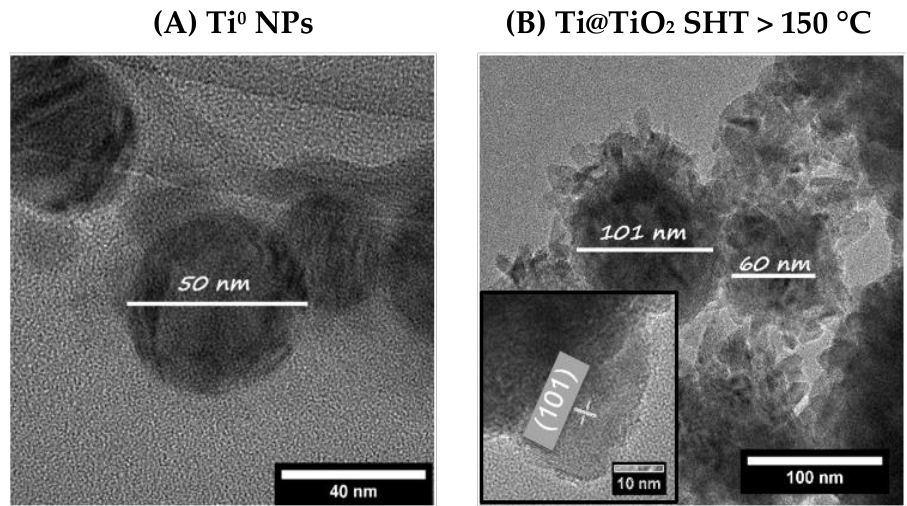
Figure 1. Typical HR TEM images of Ti 0 ( A ) and Ti@TiO 2 ( B ) NPs. In the inset, the distance of 0.35 nm corresponds to (101) plane of TiO 2 anatase. The analysis was performed with a Jeol 2200FS (200 kV) device.